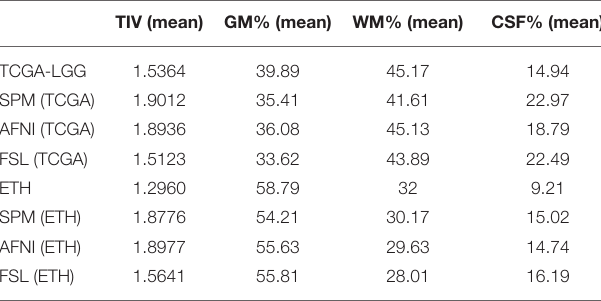
TABLE 4 | Brain volume estimation